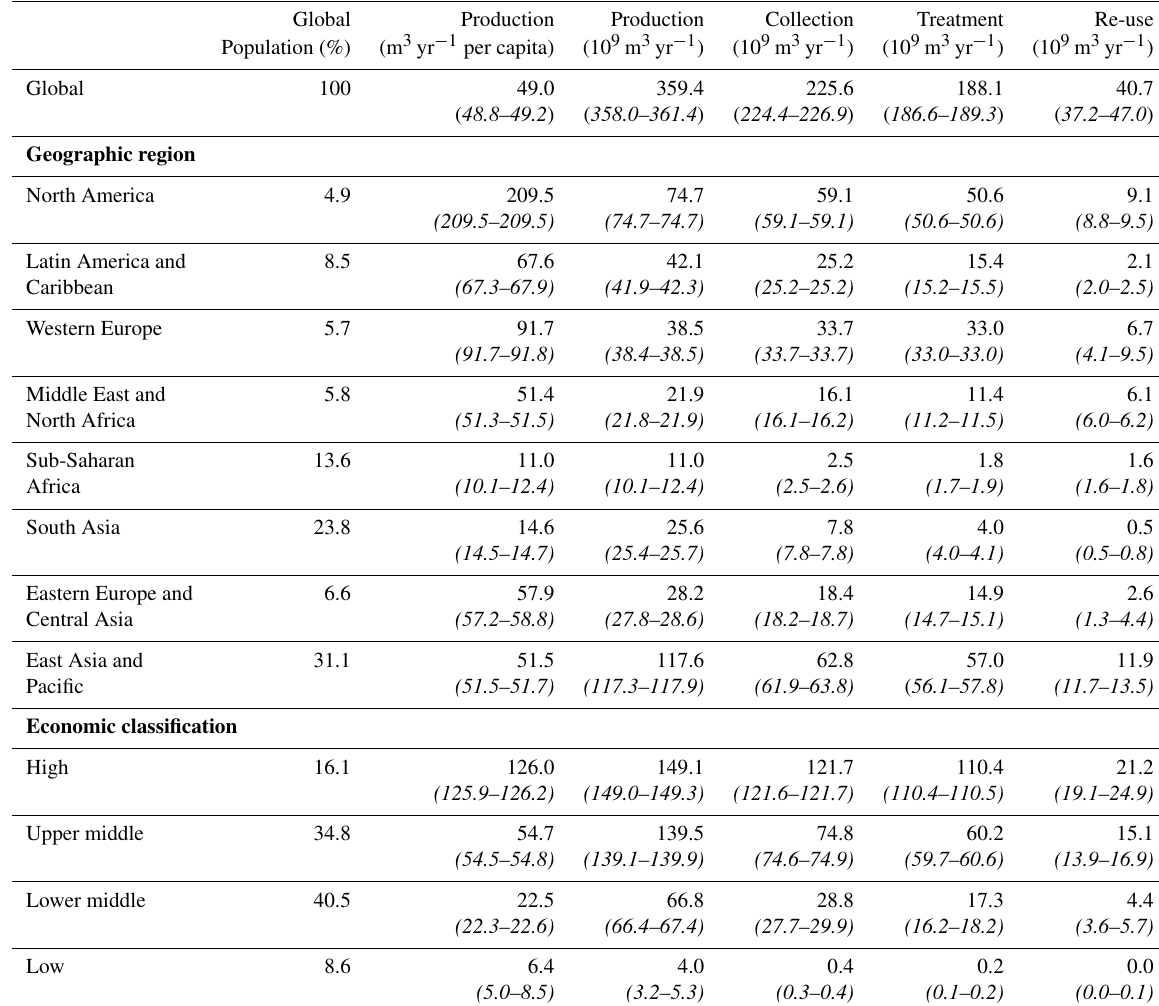
Table 4. Wastewater production, collection, treatment and reuse (10 9 m 3 yr − 1 ) by region and level of economic development. The numbers in parentheses display the prediction uncertainty (2.5th and 97.5th confidence limits, in 10 9 m 3 yr − 1 ) on the totals based on the results of 1000 bootstrap regressions with random sampling and